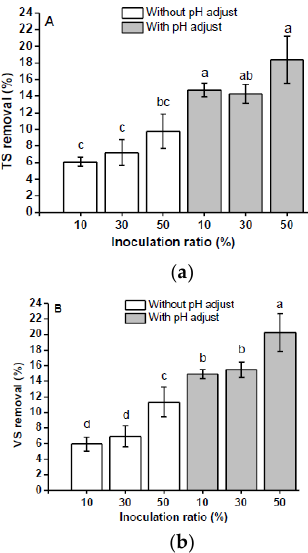
Figure 4. Effect of pH adjustment and different IR (inoculation ratios) on TS (total solids) ( a ) and VS (volatile solids) removal ( b ). Data indicate mean and its standard deviation of triplicates. Bars without the same lowercase letter(s) differ significantly ( p < 0.05).